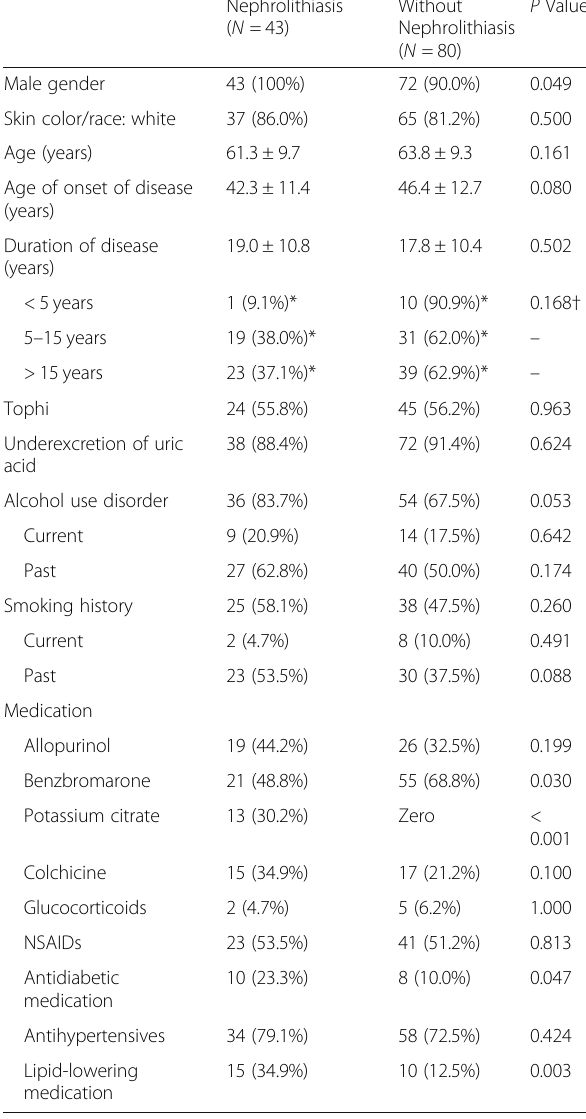
Table 4 Comparison between patients with and without nephrolithiasis (clinical N = 123